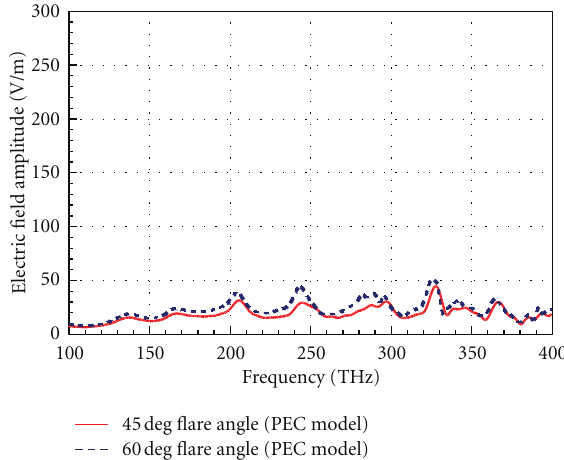
Figure 10: Electric field at the feed gap location of double bowtie for PEC model of gold.